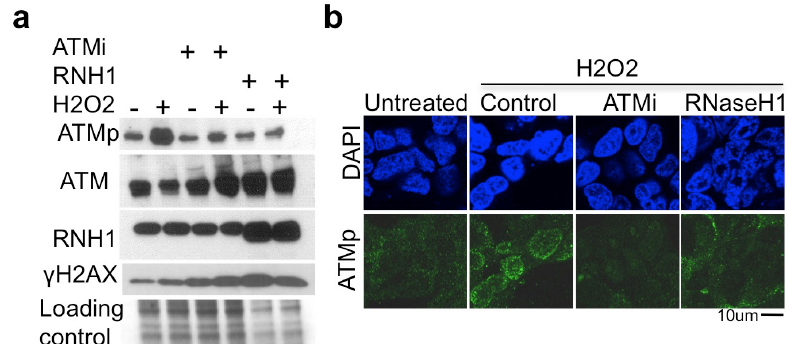
Figure 5. RNA:DNA hybrids promote ATM activation. ( a ) Western blot of cell extracts treated with H or ectopic RNaseH1 expression. Loading control is Coomassie-equivalent staining of gels, before transfer (detailed in the Methods). ( b ) Immunofluorescence of cells with antibody against ATM phosphorylated on Ser1981. Images are representative of n=4 (for a), and n=3 (for b) independent